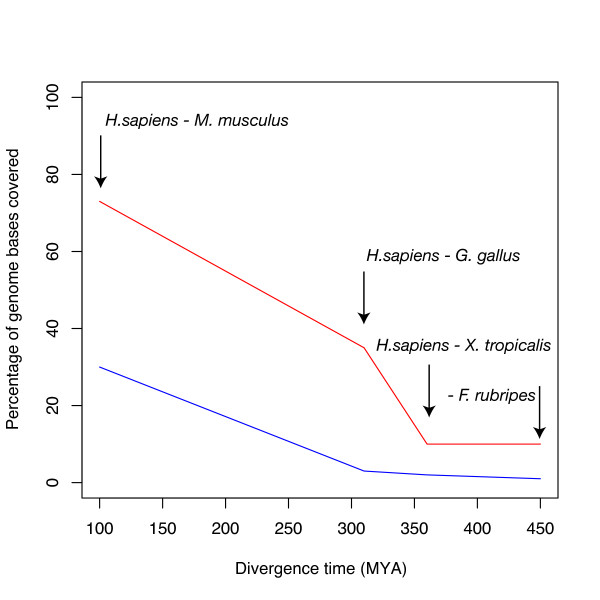
Comparison of whole genome coverage for Syntenator and UCSC blastz alignments. This figure shows the proportion (in %) of the human genome that is covered by Syntenator (red line) or UCSC blastz (blue) alignments. We performed four pairwise genome comparisons with increasing evolutionary distance (see labels). The estimated divergence times are shown on the x-axis.